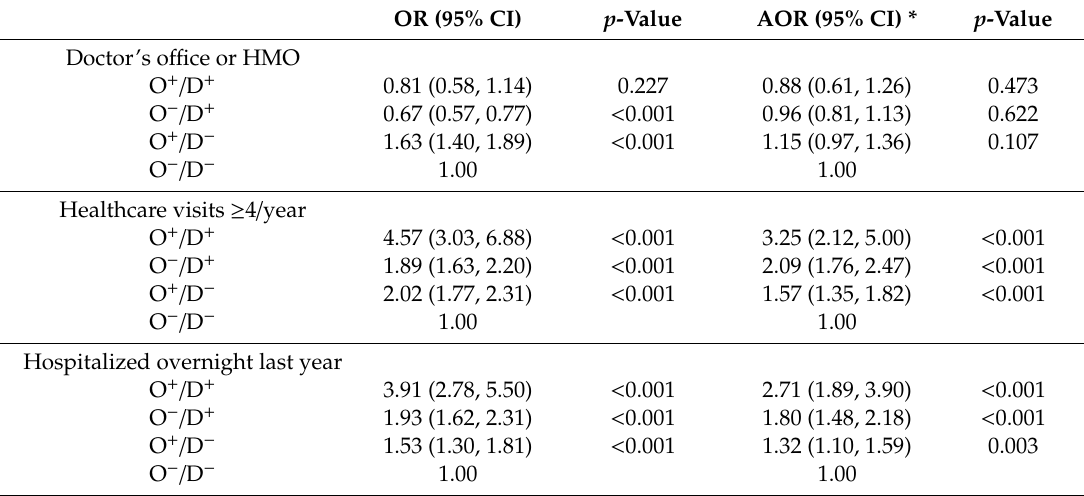
Table 5. Comparison of the risk for medical resource utilization among disease groups by unconditional logistic